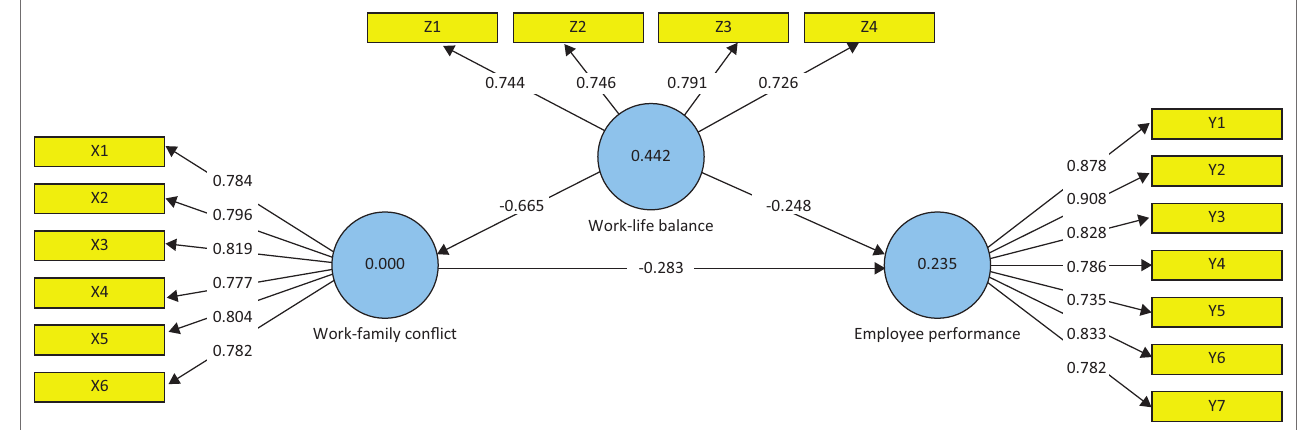
FIGURE 1: Path diagram.